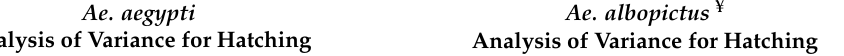
Table 1. Summary of the General Linear Models (GLM) for the evaluation of Hyalurosmooth ® and hydrolyzed collagen as preservatives of Ae. aegypti and Ae. albopictus eggs during 8 and 6 weeks, respectively, in southern